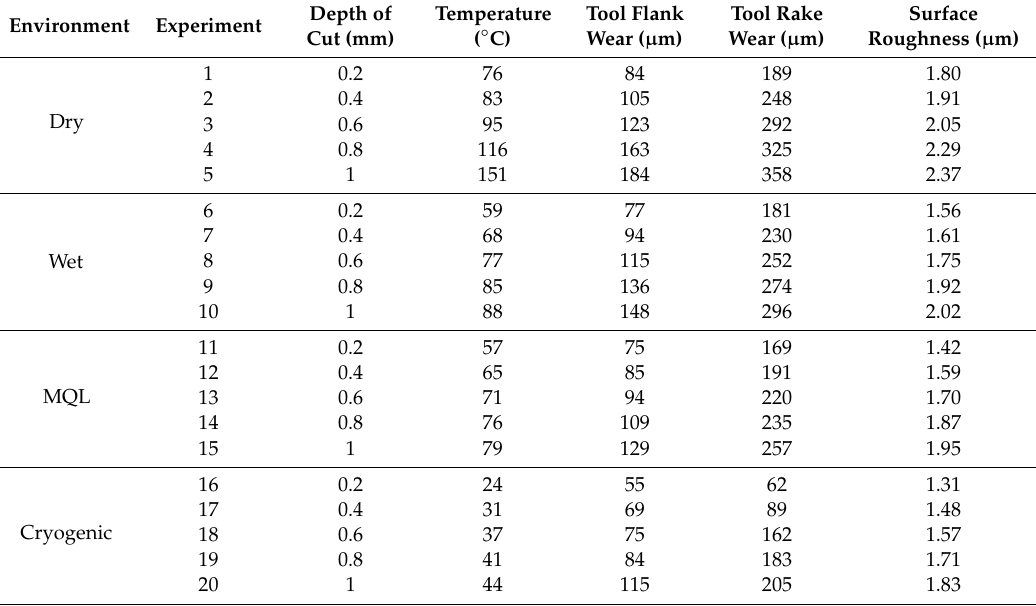
Table A1. Raw data obtained after digitizing the graphs in Sivaiah and Chakradhar